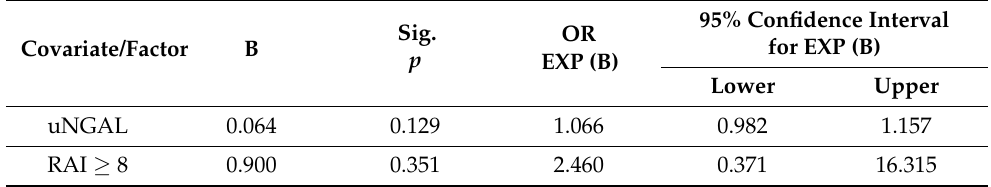
The logistic regression coefficients for the dependent variable for day 3 CrCl < 90/mL/1.73 m 2